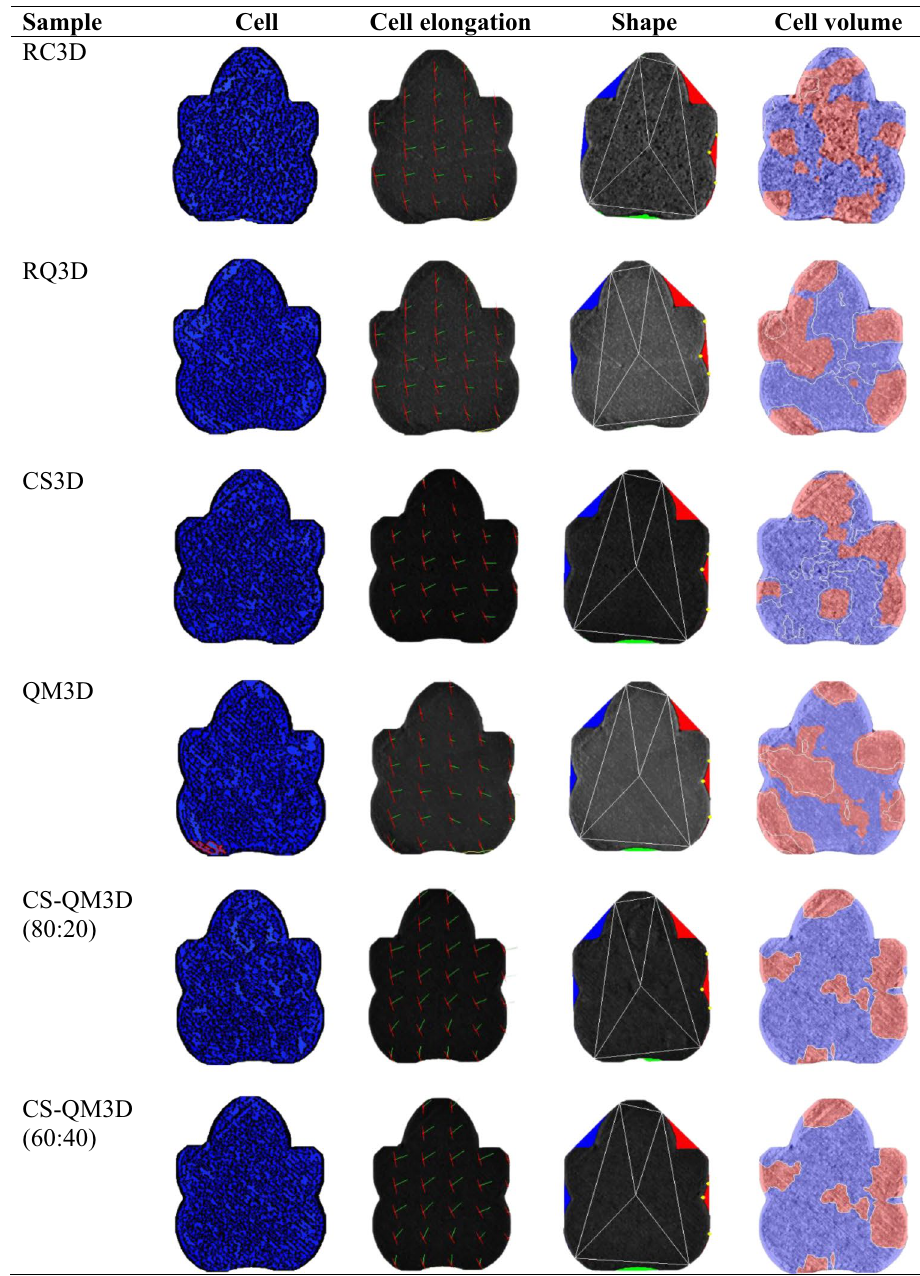
cowpea sourdough 3D-printed biscuit, QM3D quinoa malt 3D-printed biscuit, CS-QM3D (80:20) 80% cowpea sourdough and 20% quinoa malt 3D-printed biscuit, CS-QM3D (60:40) 60% cowpea sourdough and 40% quinoa malt 3D-printed